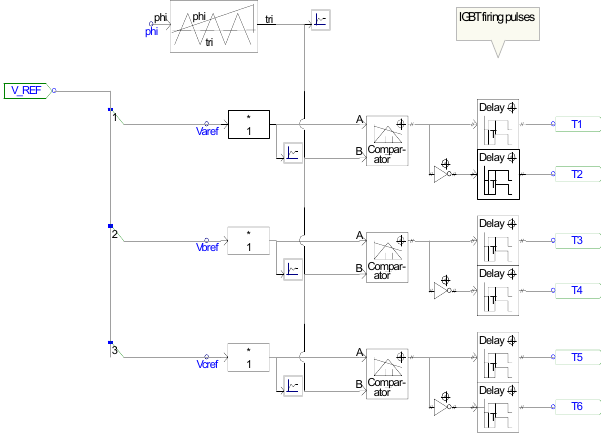
Figure A5. PWM control of the grid side converter.